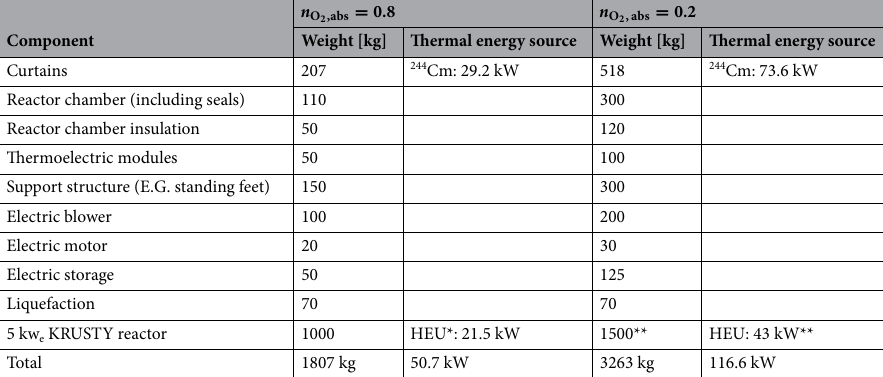
Table 12. Estimation of the weight of the POP system components (without shielding) and the primary thermal performance. *Highly enriched uranium (HEU) 55 . **10 kw e KRUSTY Reactor.